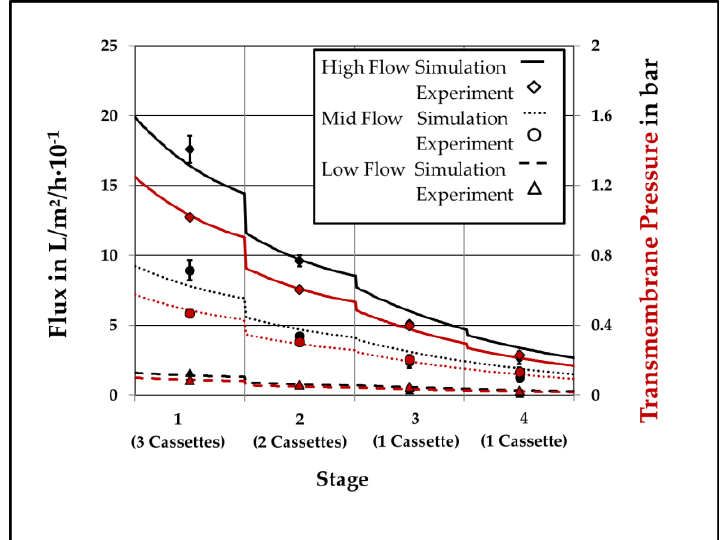
Figure 8. Comparison of flux and transmembrane pressure development of clean water resistance tests for experimental and simulated data.